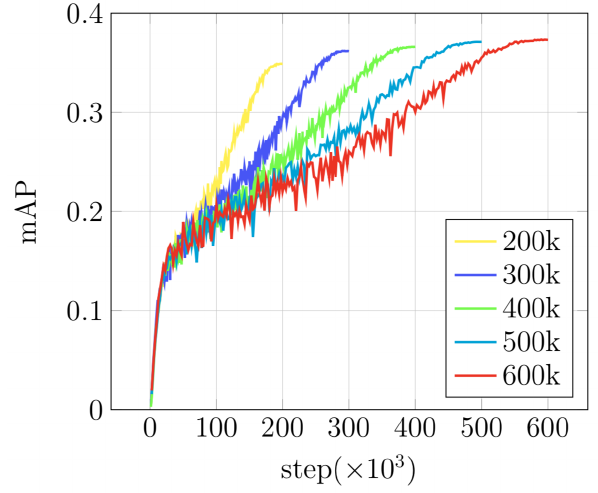
Figure 6. Comparisons of evaluation curves with longer training steps. RetinaNet with ResNet-50 backbone was trained by a momentum optimizer with cosine decay and evaluated on the COCO val2017 dataset.